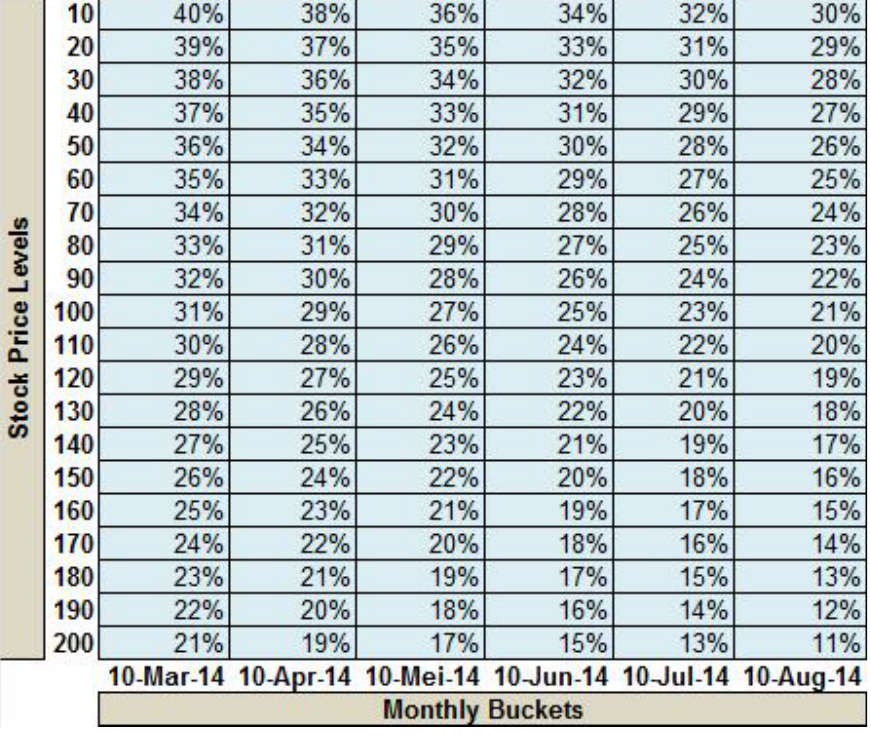
Figure 4. A grid or matrix showing possible local volatilities per time bucket and price